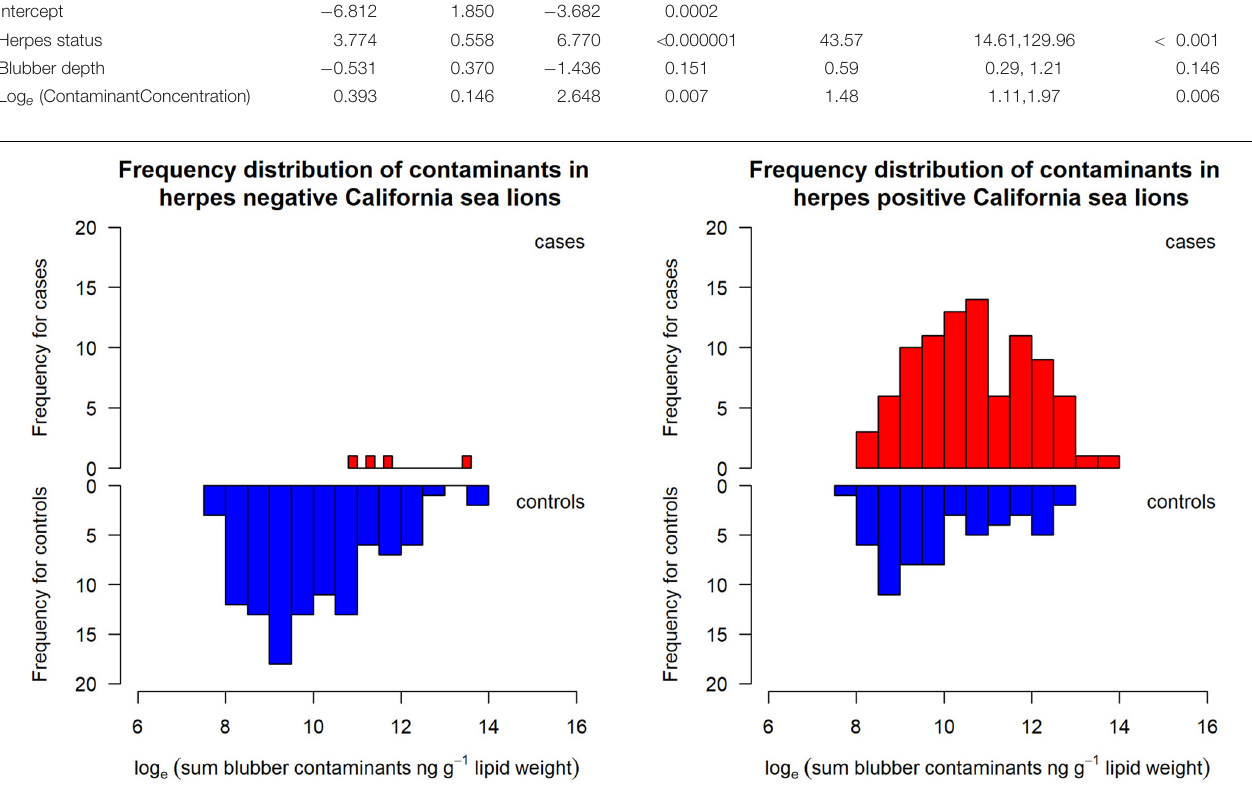
blubber concentrations and without herpesvirus have a less than 20% probability of being a cancer case whereas for an animal with herpesvirus this increases from about a 30% probability in the least exposed to over 80% in the most